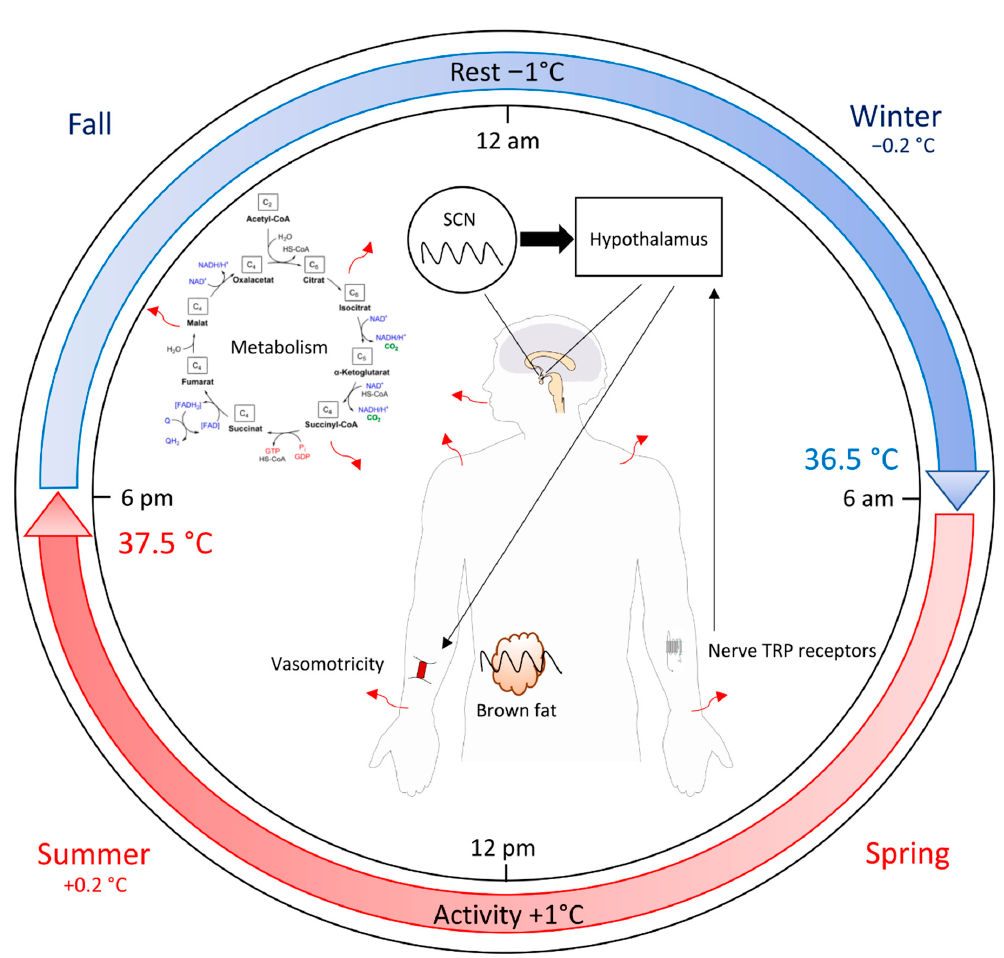
Figure 1. Origin, control, and variation of the body temperature in humans. The heat production is generated by the metabolism and the activity resulting in an increase of body temperature during the day. Heat loss is the consequence of sweating or vasomotor changes that regulate blood flow to the skin and mucous membranes via nerve sensors (thermal TRP) of the temperature and coordinated by the hypothalamus. Temperature oscillation is synchronized by the SCN but may also be generated by the brown fat driven by their cell molecular clocks. Red arrows represent the heat. The climate environment results in a change in body temperature around 0.2 ◦ C between winter and summer. SCN—suprachiasmatic nucleus; TRP—transient receptor